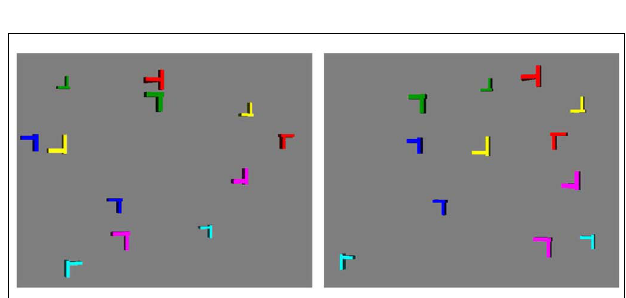
FIGURE 7 |Top panels show the results for the different viewpoint images for the learning and test phases in the stay and move conditions. The bottom panels show the results with the same retinal images for the learning and test phases in the move condition.The vertical axis indicates the